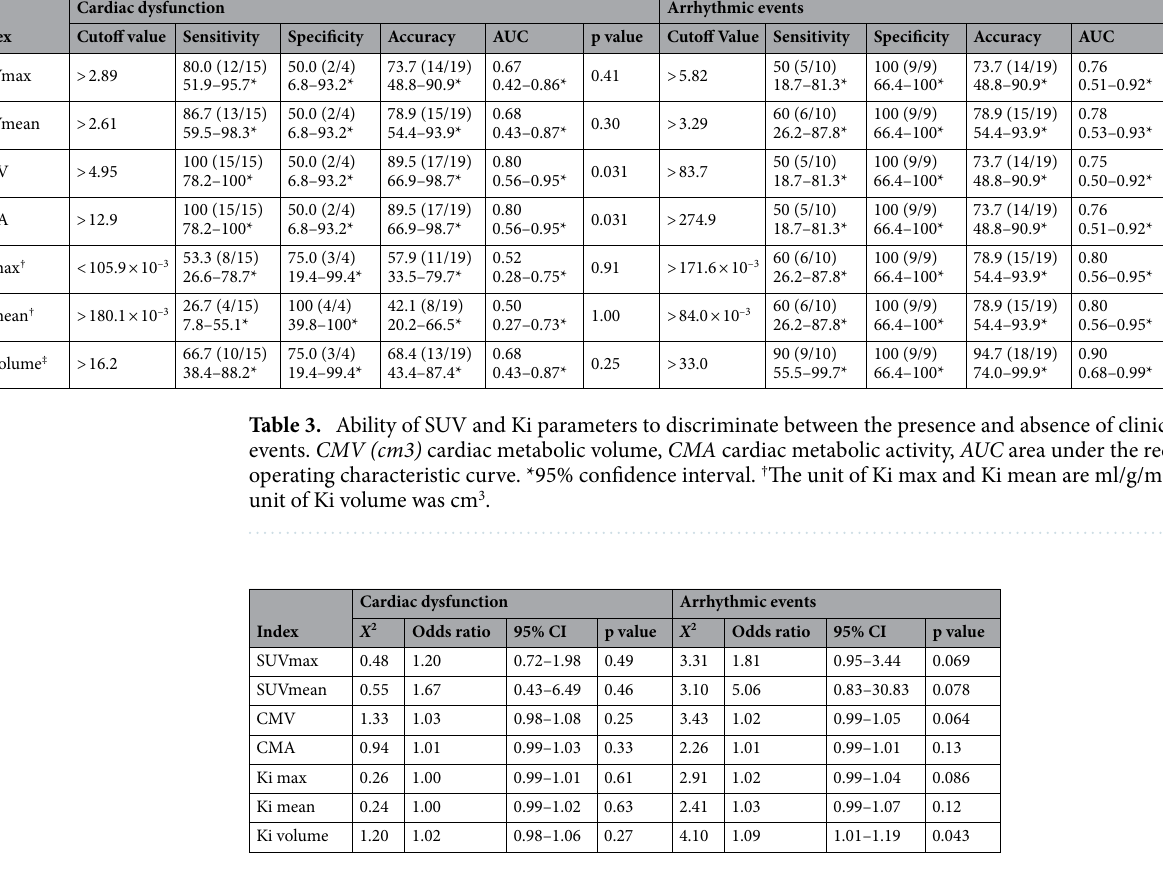
Table 4. Logistic analysis for association between each parameter and presence of clinical events. CMV cardiac metabolic volume, CMA cardiac metabolic activity, CI confidence interval.